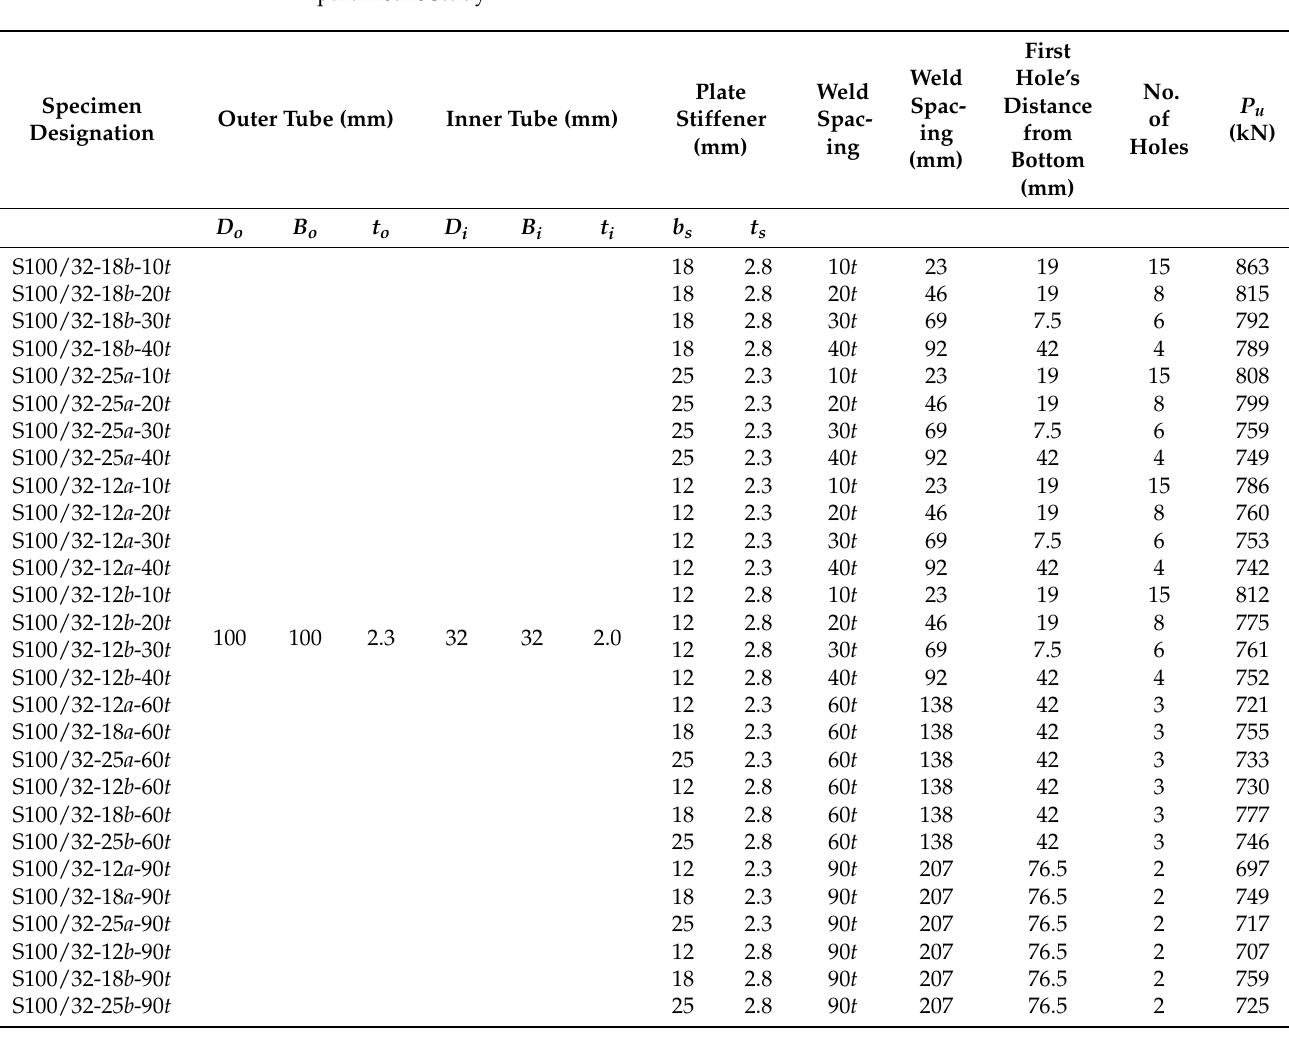
Table 9. Geometric and material properties of the stiffened square CFDST stub column for the parametric study.